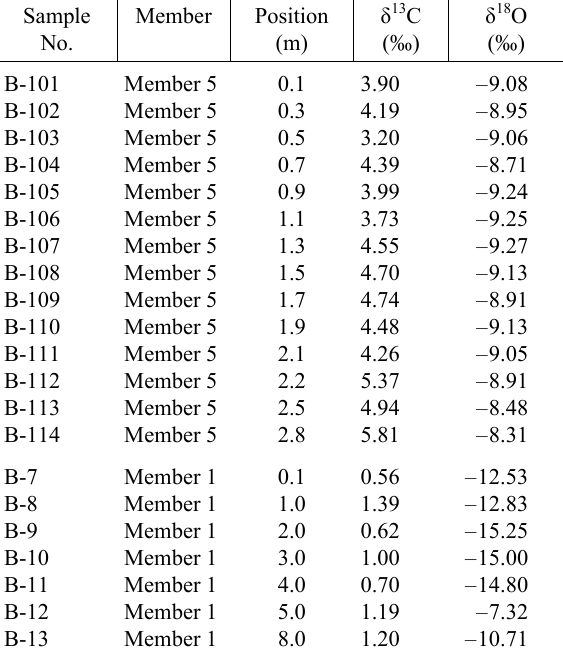
Table 1. Carbon and oxygen stable isotope composition of the samples from the Tekhten  Formation, Burovlyanka section. The position of the samples is measured from the top of Member 5 and Member 1,